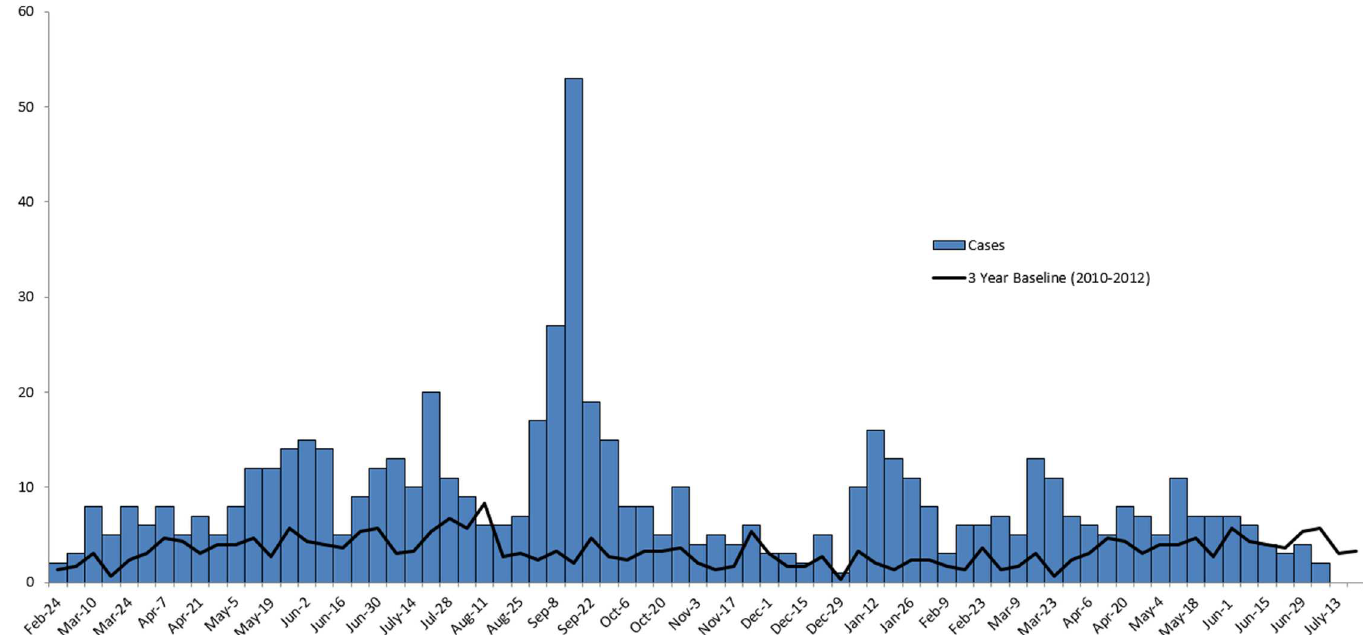
Fig 2. Persons Infectedwiththe Outbreak Strainsof Salmonella Heidelberg by State,n = 634, 2013–2014.